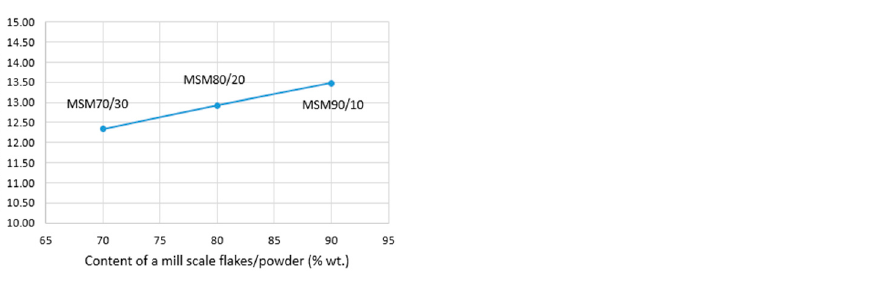
Figure 25. SE dependence of density. Iron scale mix of flakes and powder. Frequency—10 GHz.